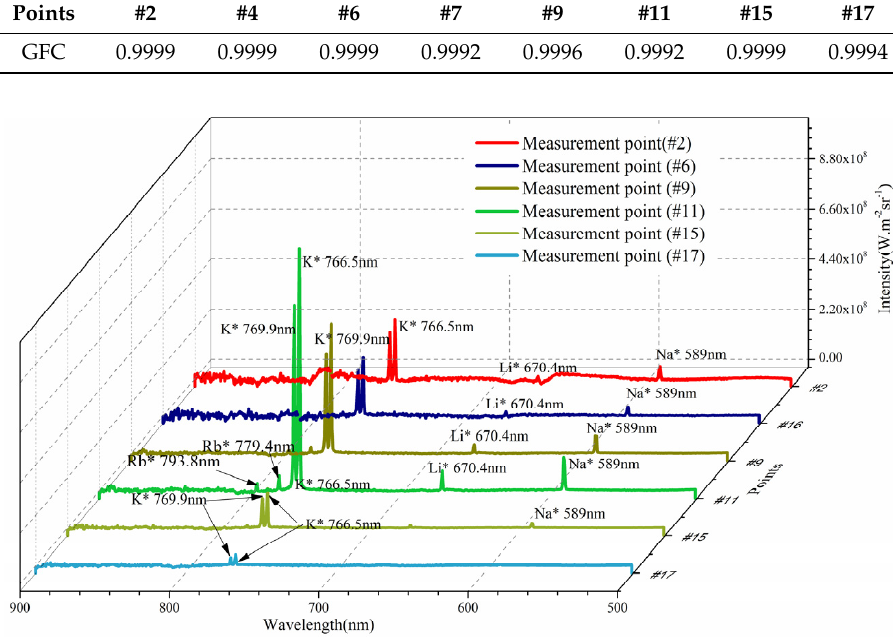
Table 2. The goodness-of-fit coefficient (GFC) values of selected profiles.